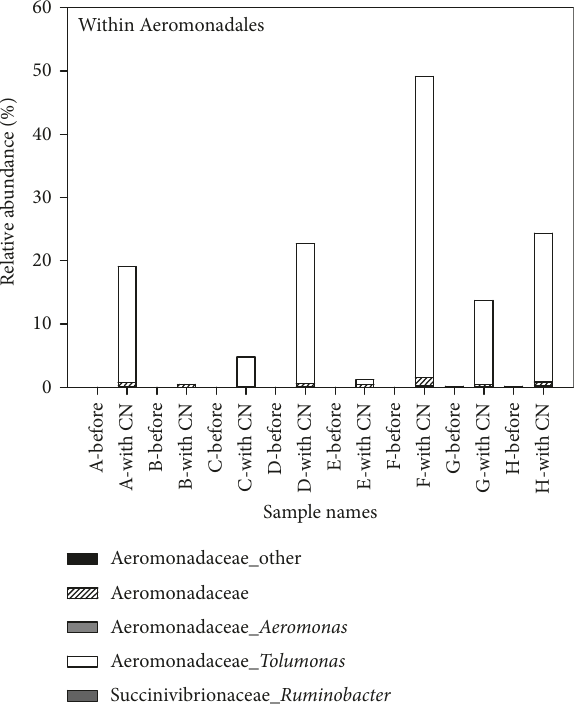
Figure 2: Changes in relative abundance of classes within the order Aeromonadales (within Proteobacteria Gammaproteobacteria ), based on 16S rRNA analysis before and after the addition of C and N. The capitals A to H define the sampling sites. The word “before” describes the data before the addition of C and N whereas “with C and N” suggested the data from the soils with added C and